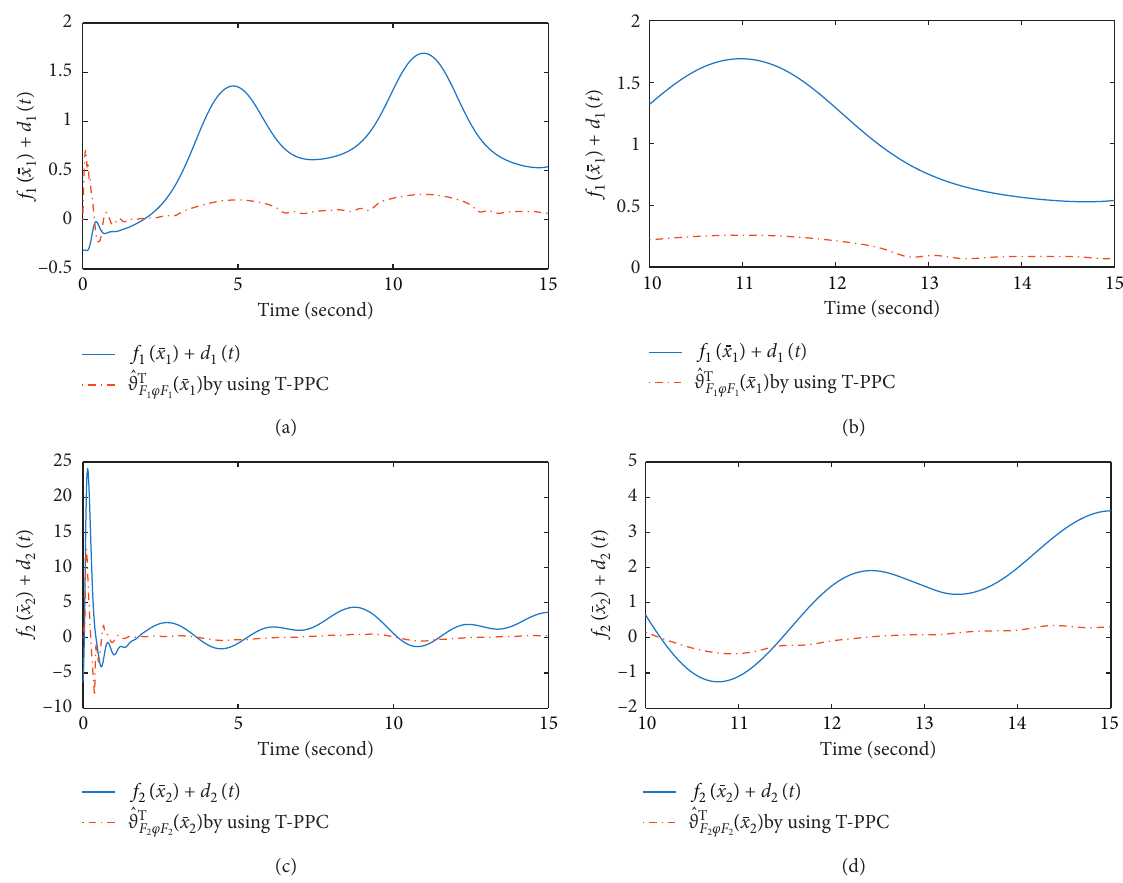
( x ) + d ( t ) by using T-PPC in time period (a) [0, 15 s]; (b) [10s, 15s]; estimation of f 1 1 1